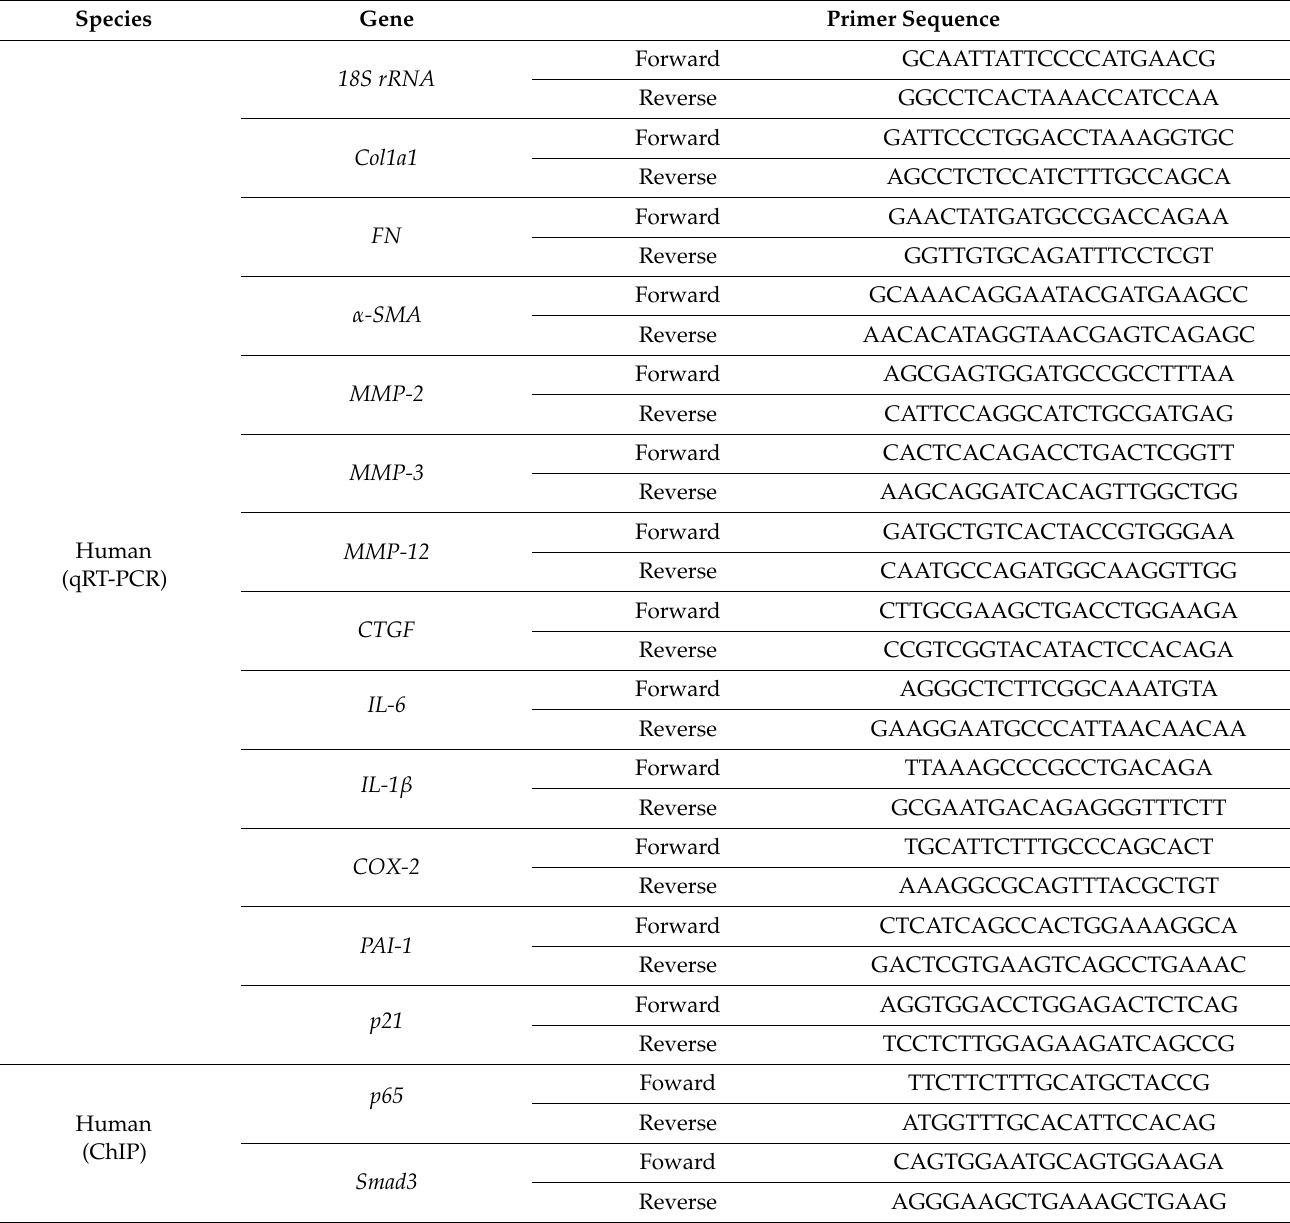
Table 2. Primer sequences for qRT-PCR and ChIP